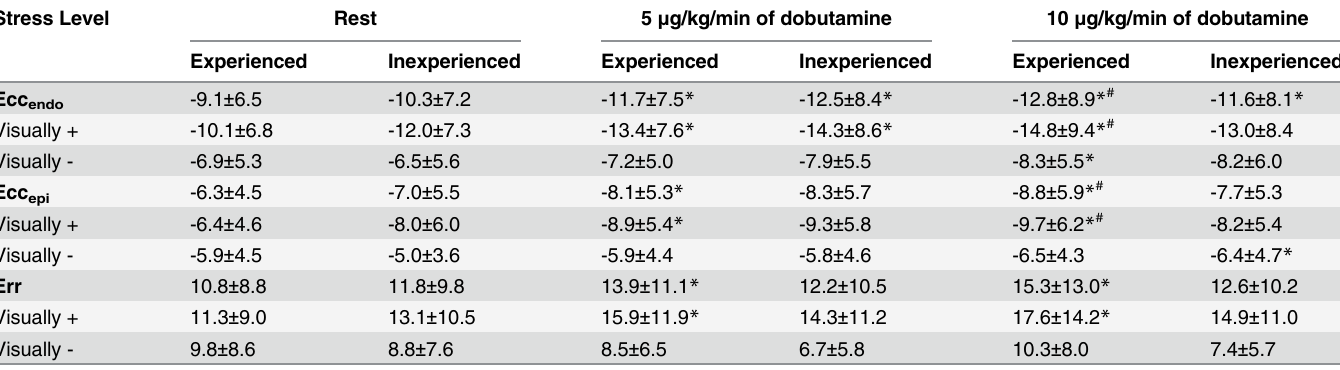
Table 2. The table shows strain values of dysfunctional segments at rest, 5 and 10 μ g/kg / min of dobutamine as determined by one experienced and one inexperienced observer. Stress Level